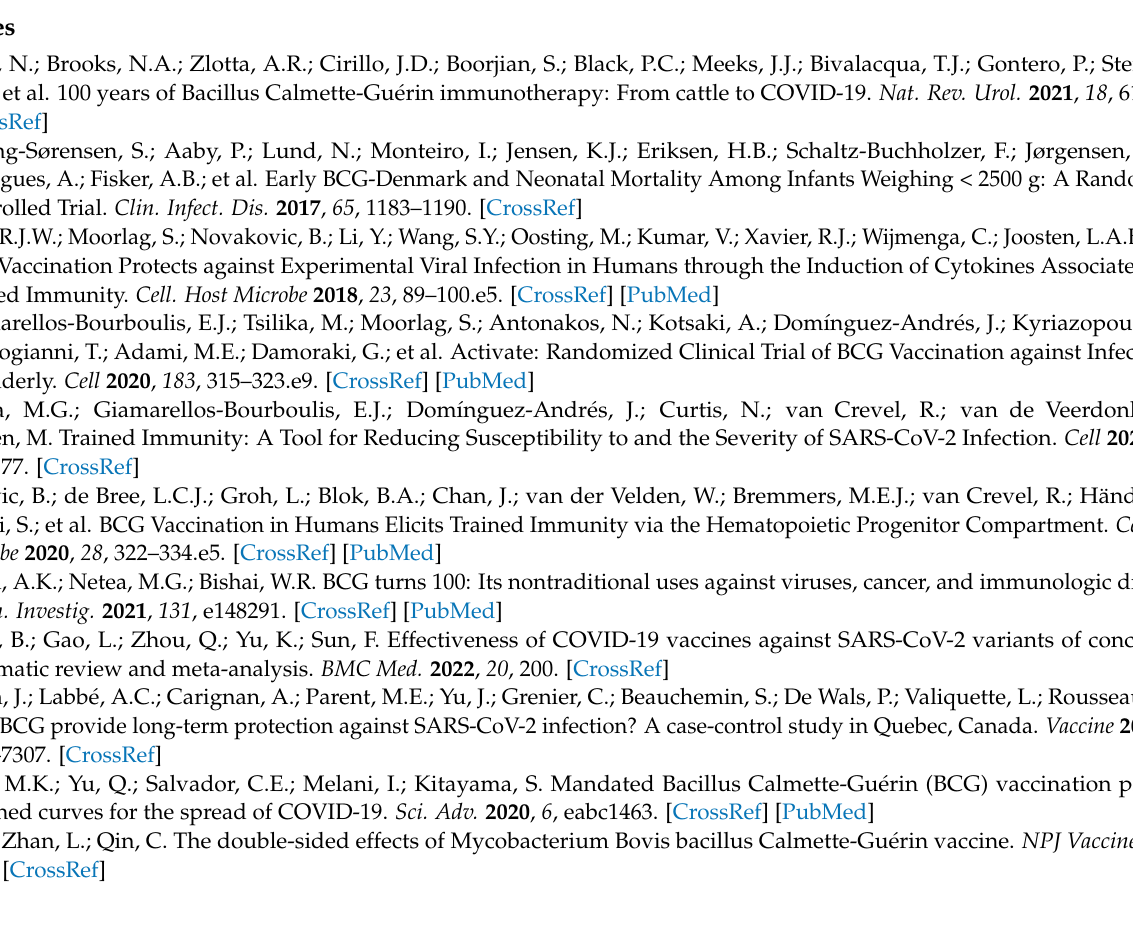
Figure SA1: Subgroup analysis for the incidence of COVID-19 between the BCG vaccination group and the control group based on BCG strain; Figure SA2: Subgroup analysis for the incidence of local injection response between the BCG vaccination group and the control group based on BCG strain; Figure SA3: Publication bias analysis of the (a) COVID-19-related hospitalization; (b) COVID-19- related mortality; (c) serious